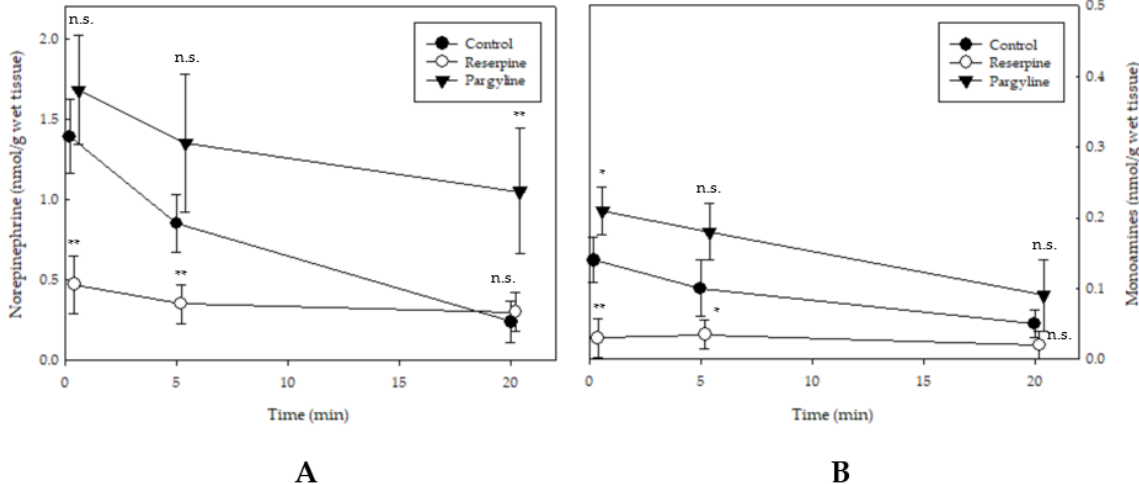
Figure 4. Variation of norepinephrine ( A ) and other monoamine levels (dopamine, B ) in the spinal cords of red seabreams administrated with indicative pharmacological inhibitors. Fish subjected to different treatments are represented as: ● (control), ○ (10 mg reserpine), and ▼ (pargyline). Statistically significant difference is shown as * p < 0.05, ** p < 0.01. Not significant, n.s.